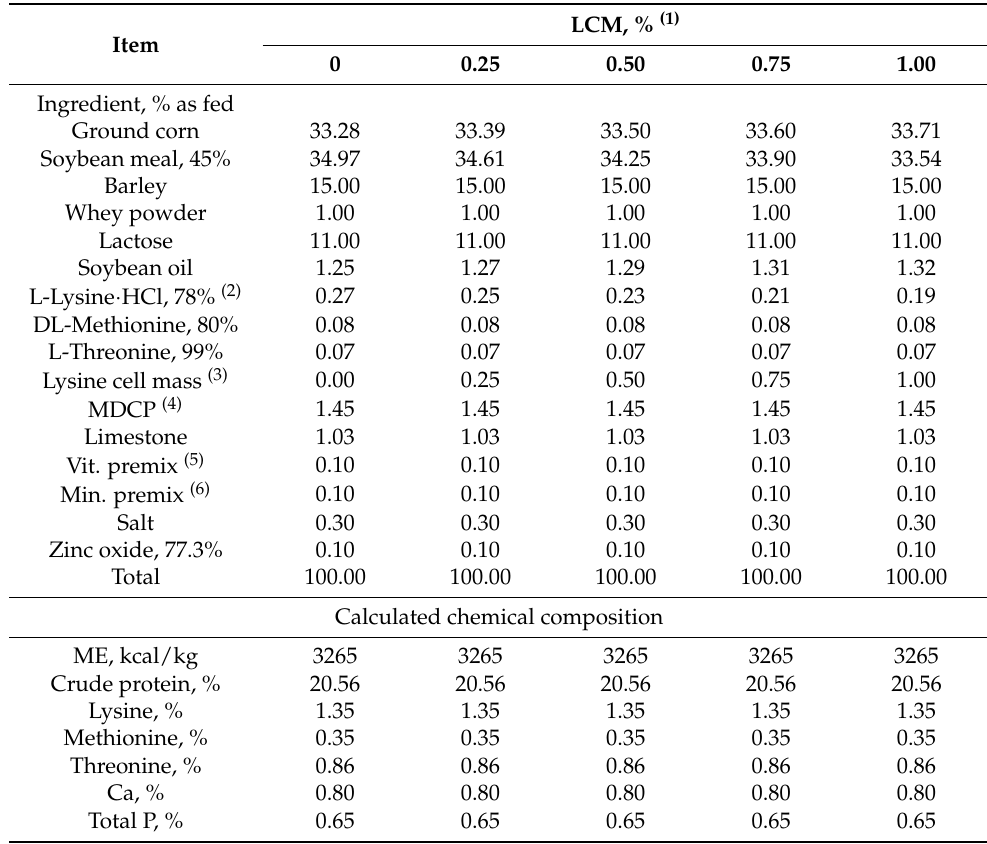
Table 2. The diet formulation and chemical composition of experimental diets for experiment 1 (phase